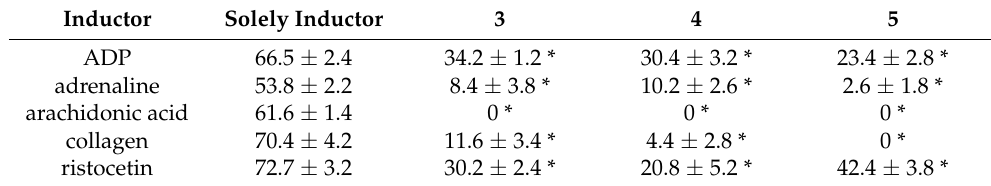
Figure 1. Influence of compounds 3 – 5 on platelets’ activation induced in vitro. * p < 0.001 in comparison with indicators without substance. Table 1. Influence of compounds 3 – 5 on platelets activation induced in vitro. The percent of induction is